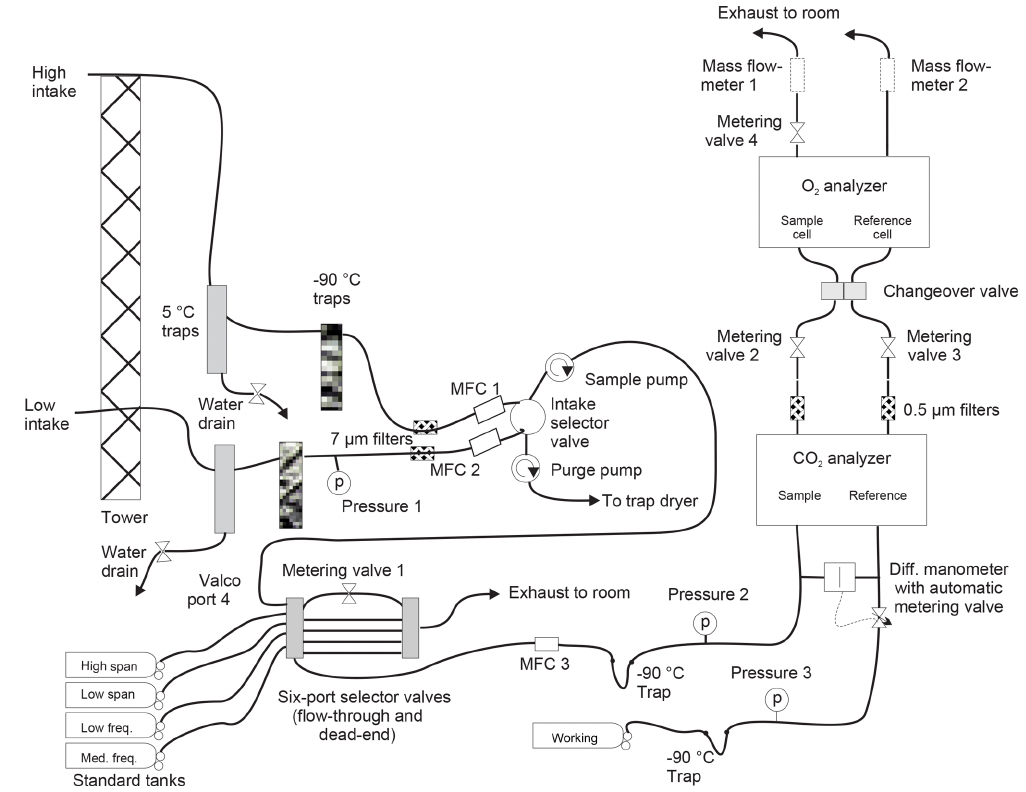
Figure 1. Schematic diagram of the instrumentation installed at Harvard